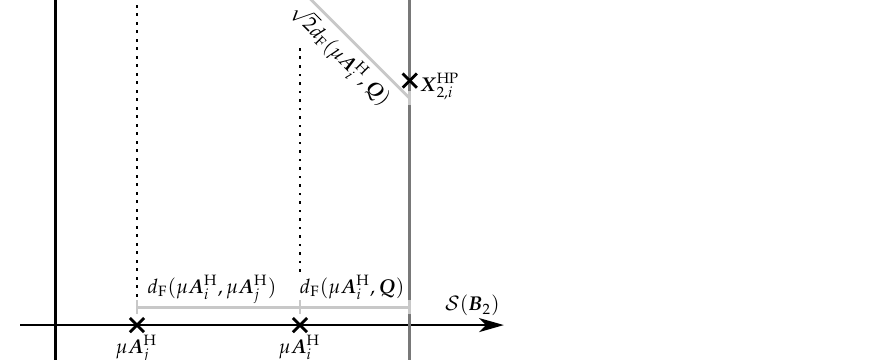
Figure 8. Graphical representation of the distances used in (28) to set the value of µ for T